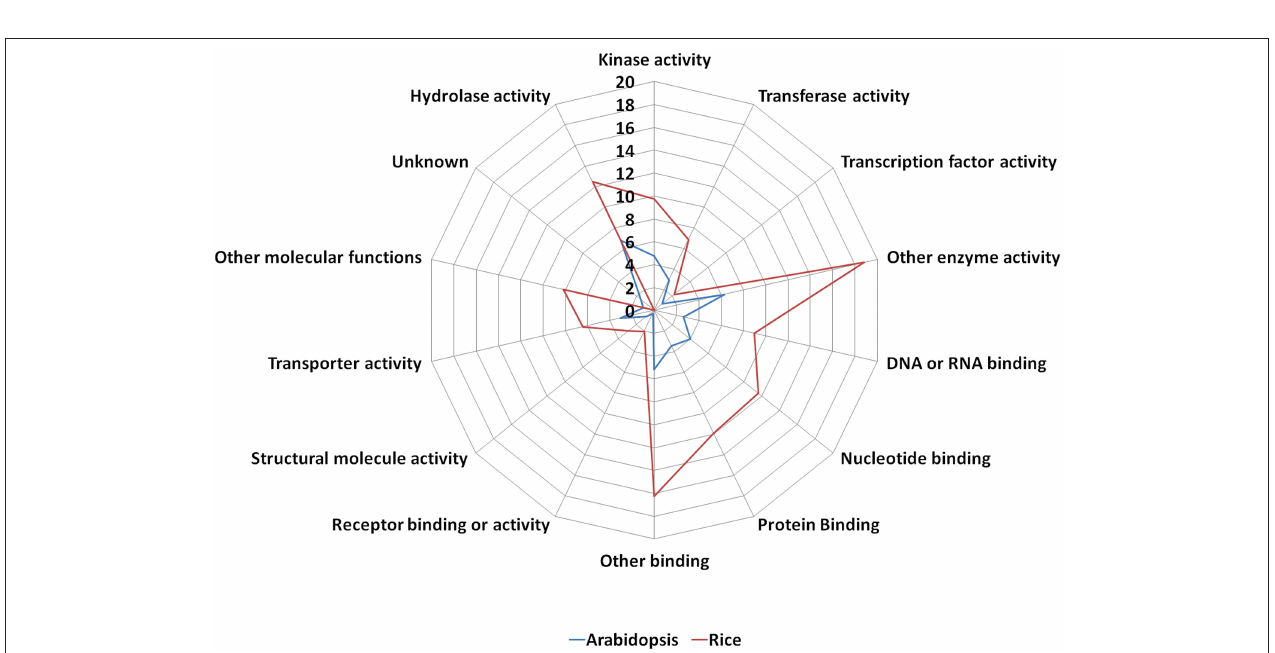
FIGURE 4 | The function of old “prokaryotic” proteins in Arabidopsis (blue) and Oryza sativa (red) showing the difference in the magnitude of proteins involved in various activities in the two plant species. The numbers represent the percentage of old “prokaryotic” proteins involved in various activities in the two plant species. It is interesting to note that the overall trend for the function in the two plant species remains similar. The functional annotations were obtained using the gene ontology annotation for both Arabidopsis and Oryza sativa